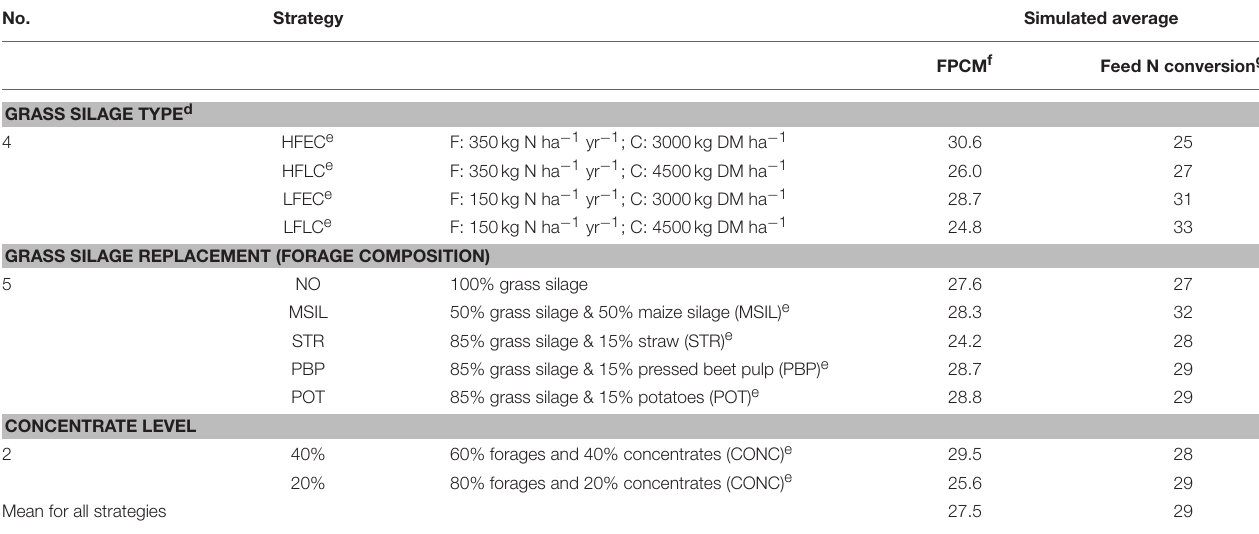
TABLE 3 | Description of selected nutritional strategies a,b,c and simulated average milk production and feed nitrogen (N) conversion.